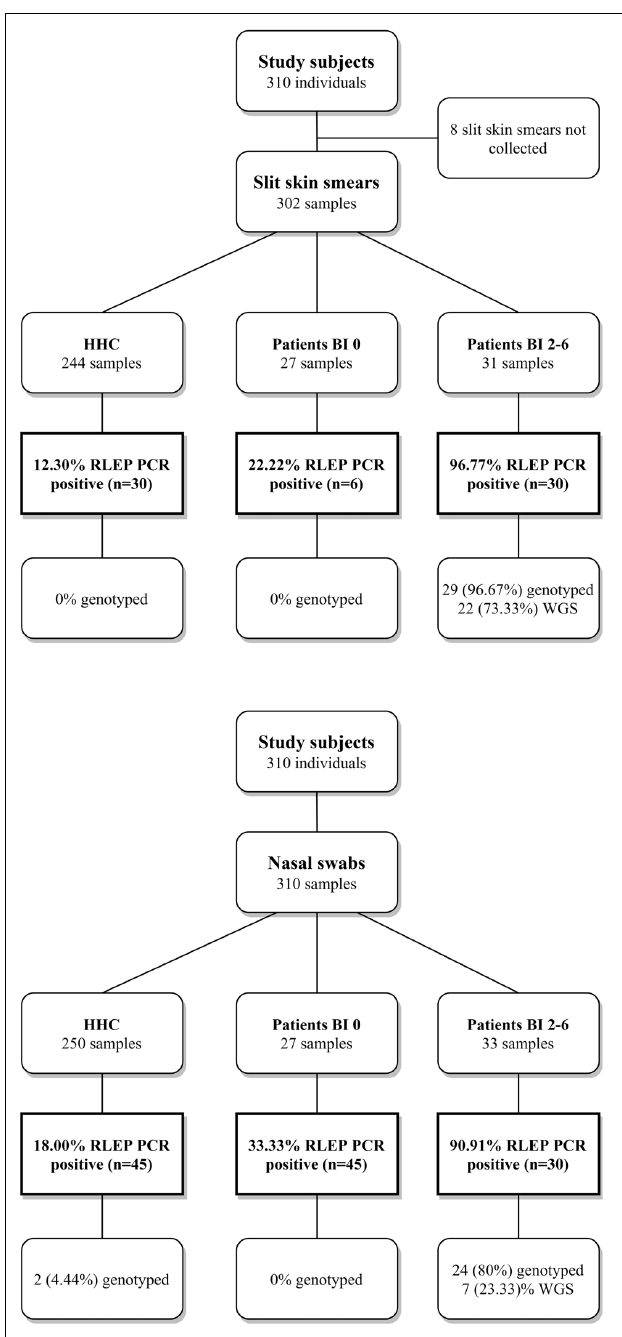
FIGURE 1 | Study design, RLEP positivity and genotyped samples. Flow diagram providing an overview of the subjects recruited for this study. Slit skin smears (SSS) and nasal swabs (NS) collected per group; healthy household contacts (HHC), paucibacillary (PB) or multibacillary (MB) patients with BI 0, and MB patients with a bacteriological index (BI) 2–6. MB patients with BI 1 were not diagnosed within the course of this study. DNA was isolated from SSS and NS and screened for M. leprae DNA by RLEP PCR. Samples were genotyped by Sanger sequencing (Monot et al., 2009; Truman et al., 2011) or Whole Genome Sequencing (Benjak et al., 2018). Percentages of the samples positive for RLEP PCR and genotyped are